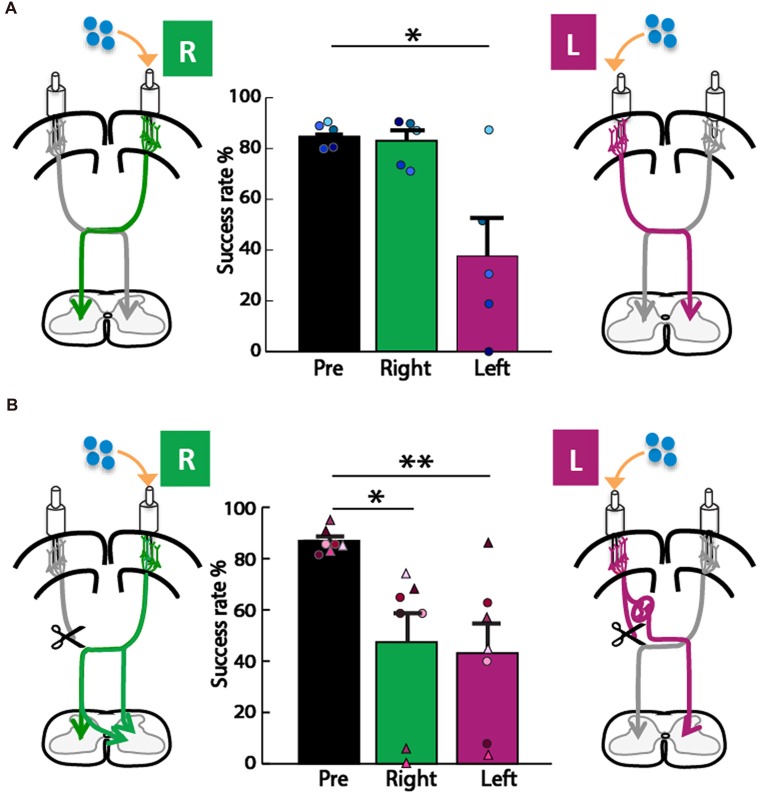
Forelimb motor control from both hemispheres in adult rats with neonatal pyramidotomy. (A) Control group. Muscimol, shown in blue, was injected into the left (L) or right (R) motor cortex. In the control rats, there was no significant difference between baseline performance (black, pre) and performance (green, right) after right motor cortex inactivation. Performance after left motor cortex inactivation (magenta, left) was significantly reduced compared to baseline performance (black, pre). Plotted dots in different shades of blue represent each rat’s success rate data points. (B) Neonatal pyramidotomy. Compared to baseline performance (black, pre), rats with neonatal pyramidotomy showed deficits in performance after both right (green, right) and left motor cortex (magenta, left) inactivation. In addition, rats with neonatal pyramidotomy showed larger impairments on the supination task than the controls after receiving right motor cortex inactivation. Plotted dots and triangles in different shades of pink represent each rat’s success rate data points. Dots in shades of pink indicate complete pyramidotomy and triangles represent rats with incomplete pyramidotomy. *p < 0.05, **p < 0.01.